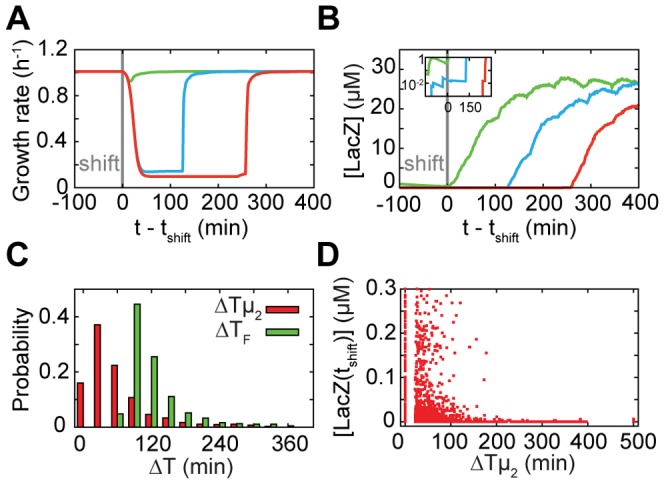
Results of the stochastic model.(A) Example time-series of cell growth rate for a cell with fast (green), slow (blue) and very slow (red) response. (B) Fluorescence time-series for the cells shown in (A). Inset: The same data on a logarithmic scale, showing that cells with higher expression levels at the time of shift of medium tend to be induced more rapidly. (C) Histograms of growth (red) and fluorescence (green) recovery times, ΔTμ2 and ΔTF. In panels (C) and (D), cells at ΔTμ2 = 0 showed a decrease in growth rate of less than 20%. (D) Lac expression of each lineage at tshift plotted against growth recovery time. Cells which did not reach the induction threshold in the time of the simulations are placed at ΔTμ2 = 500 min. Cells with initial concentrations above ∼10 nM typically have a rapid recovery of growth rate. Note that the plot range does not represent the full range of initial expression levels.